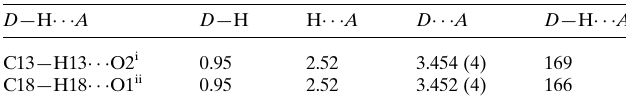
Table 1 Hydrogen-bond geometry (A˚ , (cid:2) ).